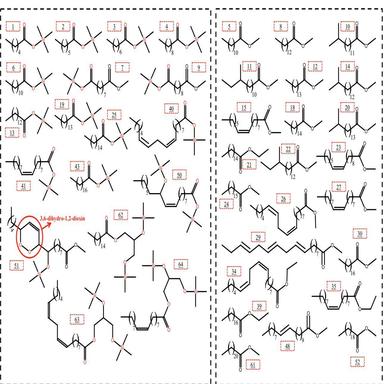
Components identified in the FEM samples after derivatization with BSTFA, (a) contaminants and (b) fatty acid esters.